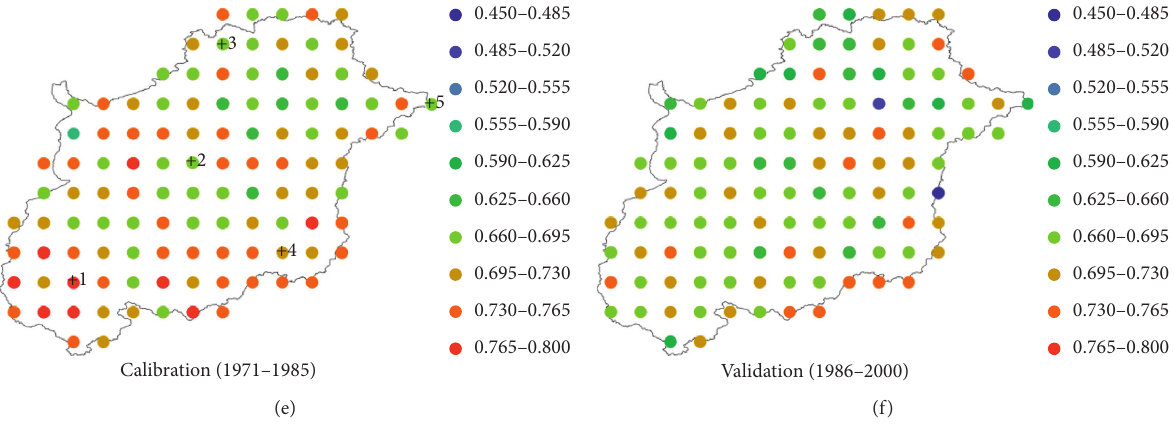
Figure 5: Pearson correlation coefficient between the observations and downscaled maximum temperature (a, b), minimum temperature (c, d), and daily precipitation (e, f) for the calibration period and validation